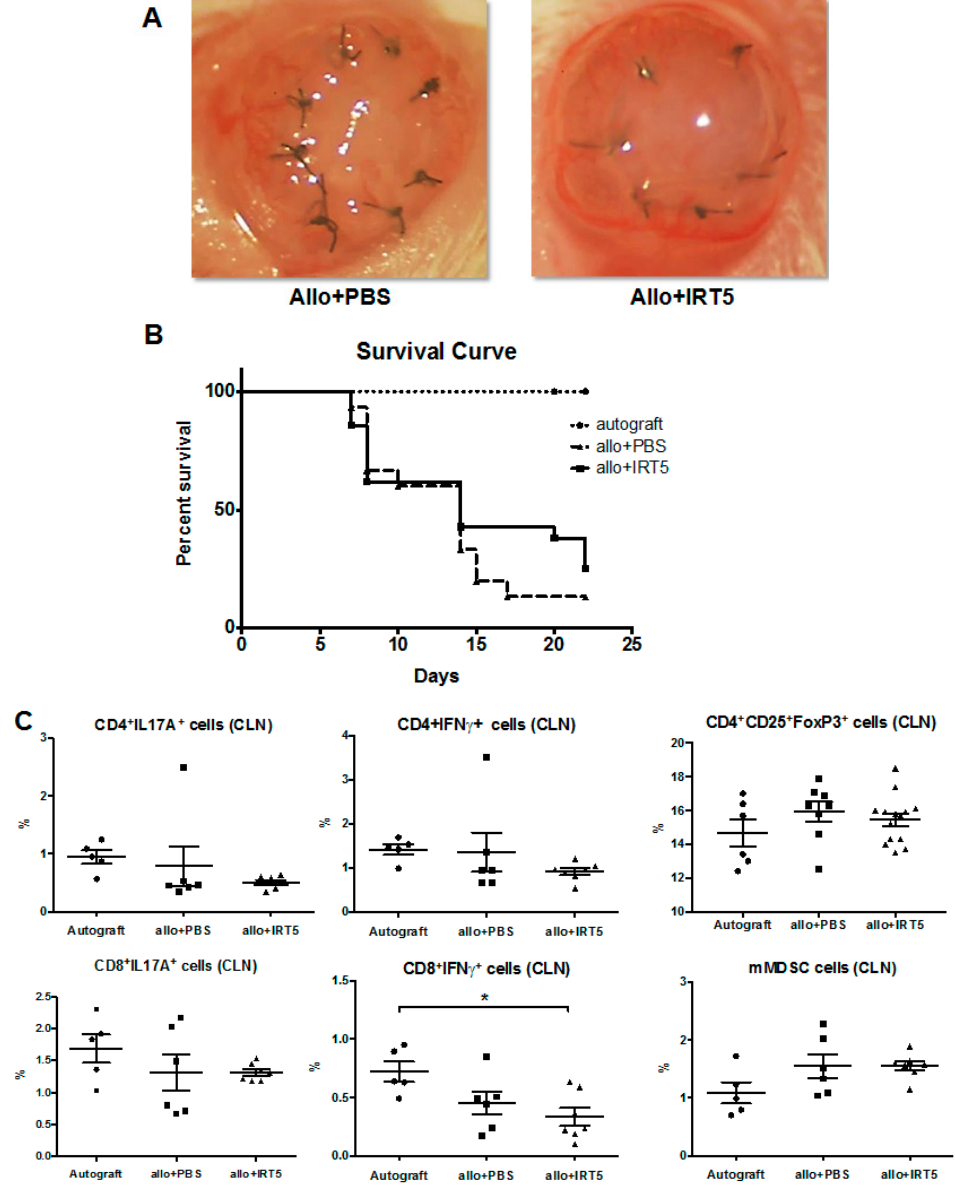
Figure 4. IRT-5 treatment does not prolong the survival of corneal allograft in B6-to BALB/C transplantation model. ( A ) Representative photographs of the cornea at day 22; ( B ) Survival curve of corneal allografts shows no statistical difference between in IRT-5-treated and PBS-treated mice ( p = 0.3413, Log-Rank test); ( C ) Data depict the percentage of IFN γ or IL-17 secreting T cells, CD4 + CD25 + Foxp3 hi Treg, and mMDSC among the total DLN cells (* p < 0.05, one-way ANOVA and Dunnett’s multiple comparisons test). There are no significant differences of T effector cells, Treg cells and mMDSC between in IRT-5-treated and PBS-treated mice.